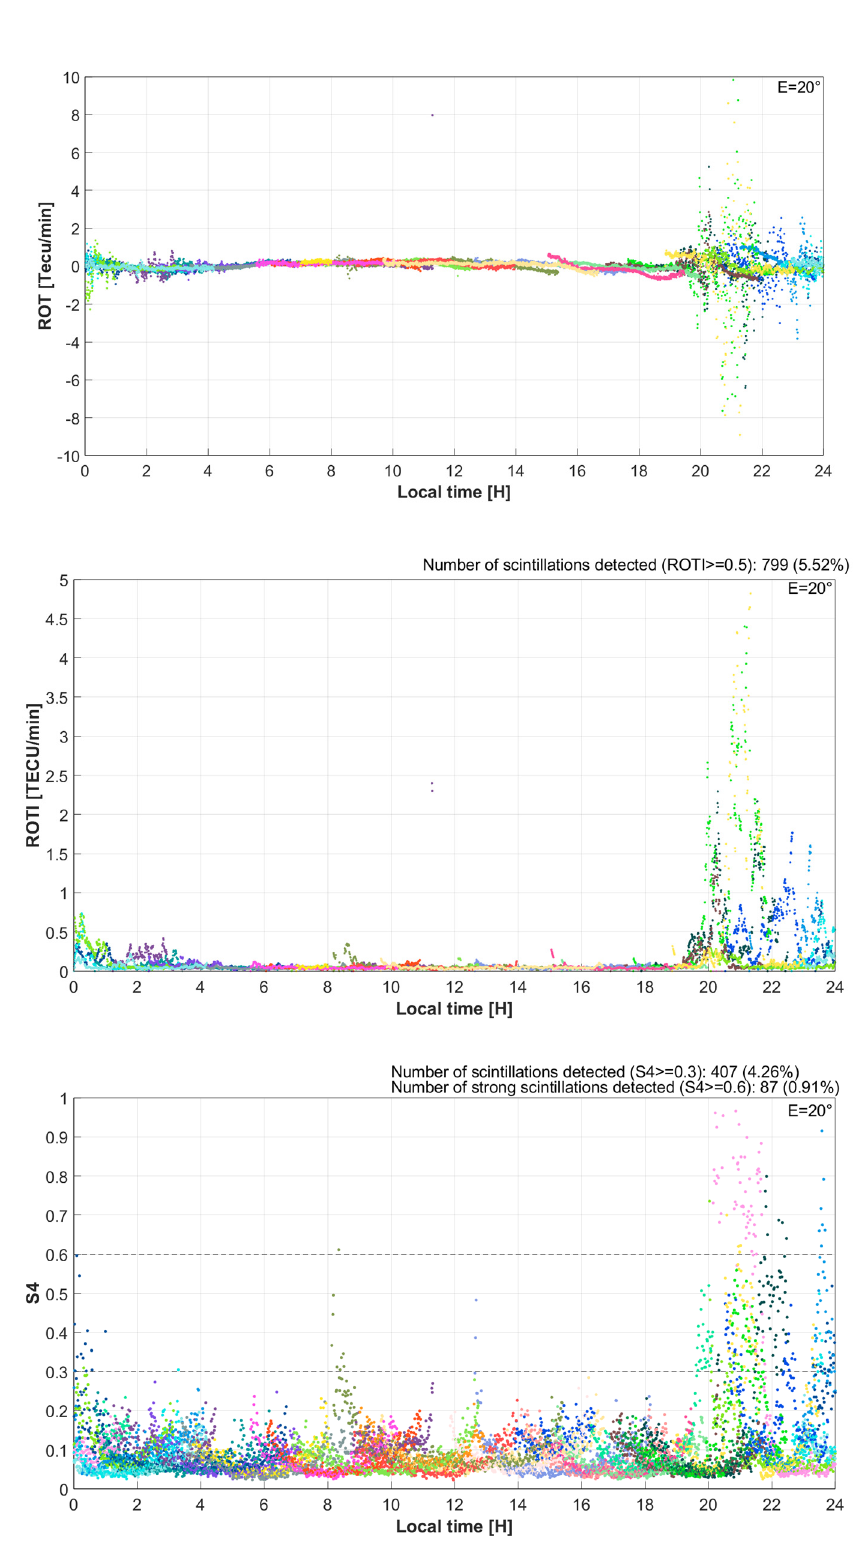
Figure 4. ROT and ROTI indices ( above ) calculated from 30 s GNSS observations at Hue station (Vietnam) on 26 March 2015 clearly show ionospheric disturbances that occurred during the period of 20–24 LT. These irregularities are also validated by the S4 index ( below ), which is directly derived from 50 Hz data. These figures show high similarity between the S4 and ROTI results. In these figures, different colored dots correspond to different satellites, and the legend “E = 20°” in the upper right corner indicates the satellite elevation cut-off used.